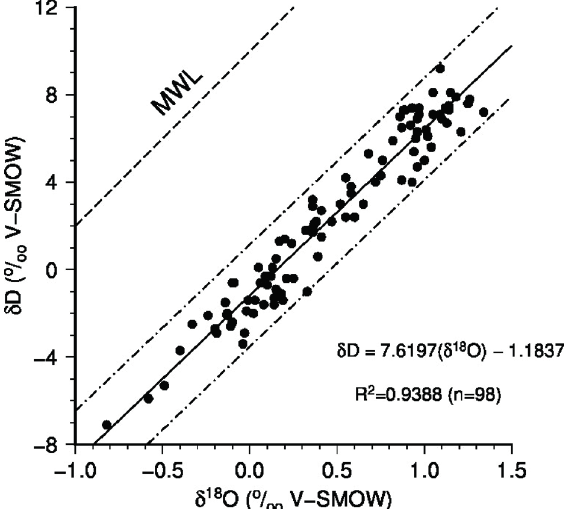
and δD with sw sw